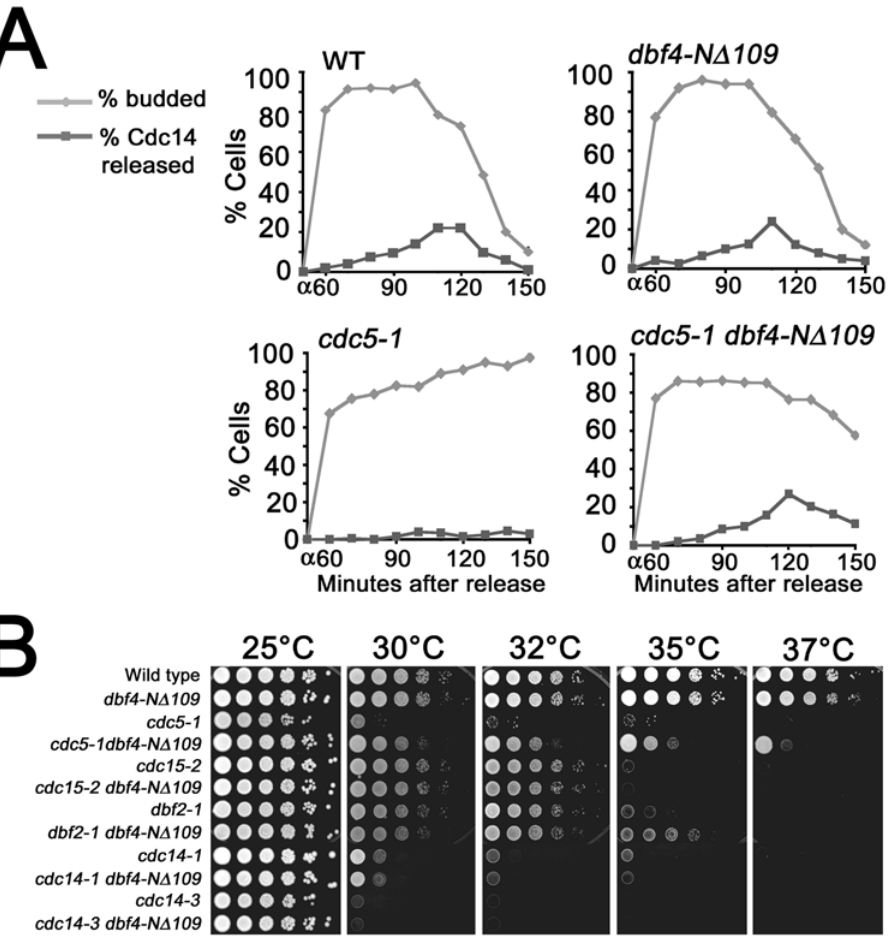
Figure 5. DBF4 inhibits Cdc14p nucleolar release and the MEN pathway. (A) Deletion of the Dbf4p PIR rescues Cdc14p nucleolar release at high temperature. M1992, M2005, M2139 and M2287 were arrested with alpha-factor at 25 u C and released into YPD at 34 u C followed by alpha-factor re-addition at 60 minutes. Entry and exit from the cell cycle was analyzed as a percentage of budded cells. Cdc14-EGFP release was analyzed in at least 100 cells at each time point and is reported as a percentage of cells with diffuse Cdc14p-EGFP nuclear staining (absence of nucleolar Cdc14p). (B) dbf4-N D 109 rescues the growth defect of the cdc5-1 and dbf2-1 strains at 35 u C. Single and double mutant strains were spotted at 10-fold dilutions on YPD and incubated at increasing temperatures for 2 to 3